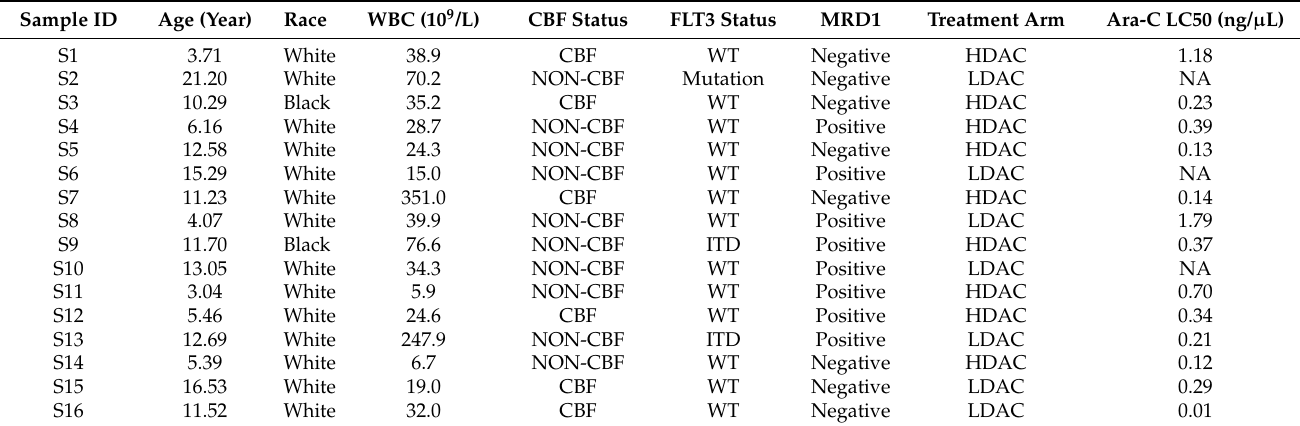
Table 1. Characteristics of 16 pediatric AML patients with CBF or Non-CBF